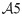
A highly idealized cartoon of different kinds of biclusters.In each panel we show a heat-map of an M × N matrix ‘D’, which contains a large embedded bicluster (highlighted in pink) with a special structure. In this cartoon, light and dark pixels correspond to high and low values for the corresponding matrix-entry. Many approaches to biclustering search for structures containing mostly ‘large’ or ‘small’ values—as shown in Panels A and B. Such a bicluster can be thought of as delineating a subset of columns which are ‘differentially-expressed’ with respect to the remaining rows of D. Our algorithm generalizes this notion, searching for biclusters that are ‘low-rank’. Examples of low-rank biclusters include those shown in Panels A and B, as well as ‘rank-1’ biclusters which can exhibit co-expression without necessarily exhibiting differential-expression (see Panel-C and Fig 5 later on). Also encompassed are ‘rank-2’ and higher biclusters which exhibit higher-order correlations that are not necessarily obvious to the eye (see Panel-D and Fig 7 later on). Note that, while the biclusters shown in this cartoon are very large and essentially noiseless, our algorithm can readily discover biclusters that are much smaller and noisier (see section A5 of S1 Text).